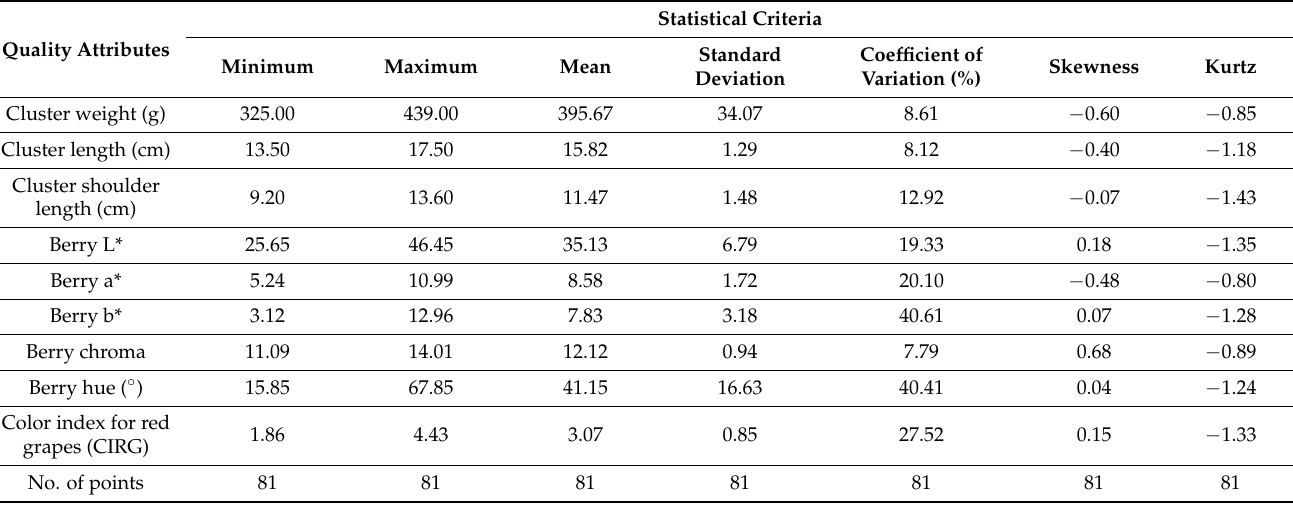
Table 4. Statistical criteria of experimental results of quality attributes of Flame Seedless grape cultivated by different agricultural practices.